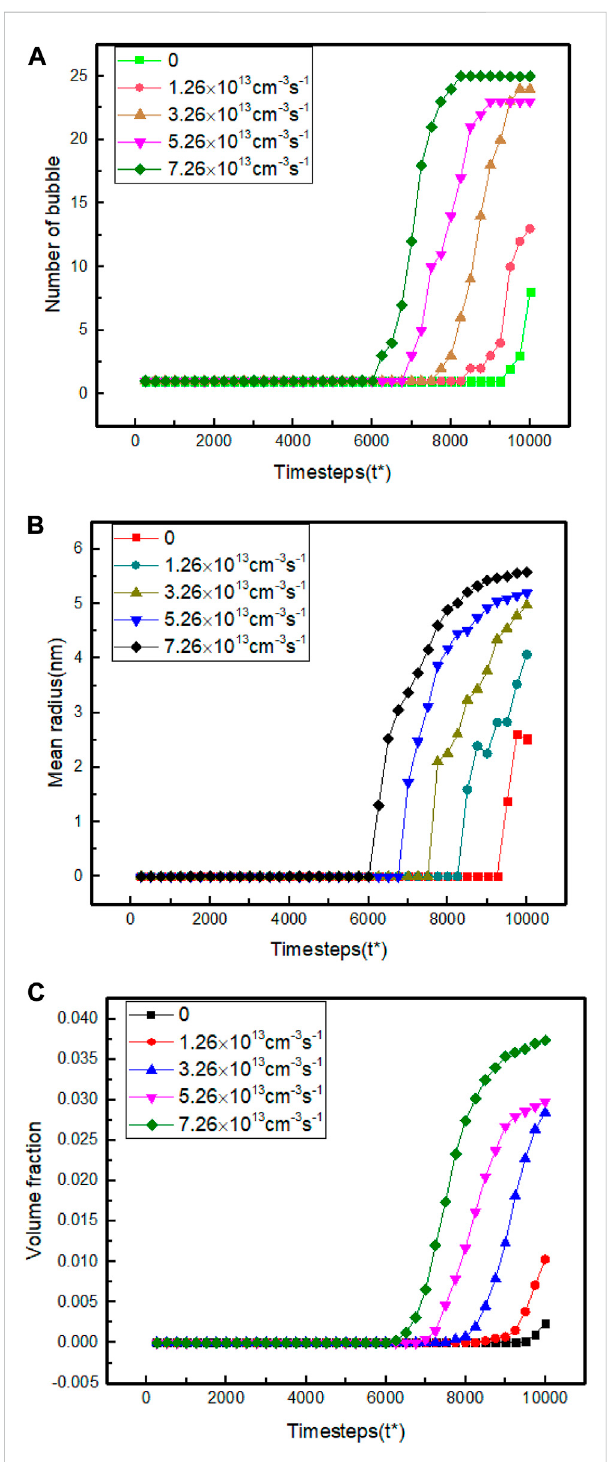
Comparison of the (A) number, (B) mean radius, and (C) volume fraction of Xe bubbles at different fi ssion